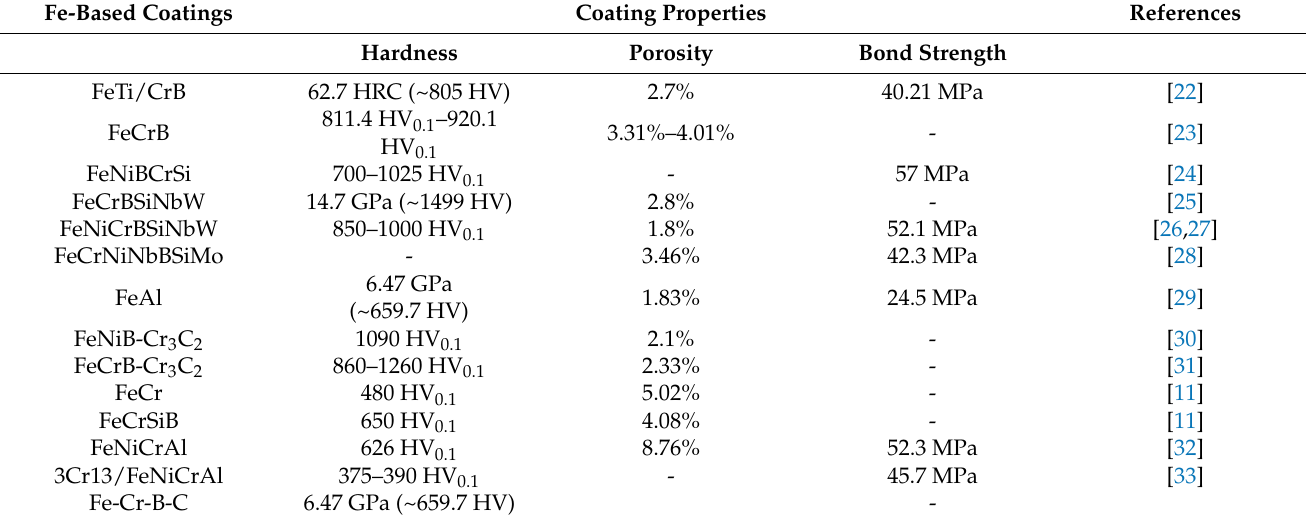
Table 1. Comparison of properties for arc-sprayed Ni-based and Fe-based